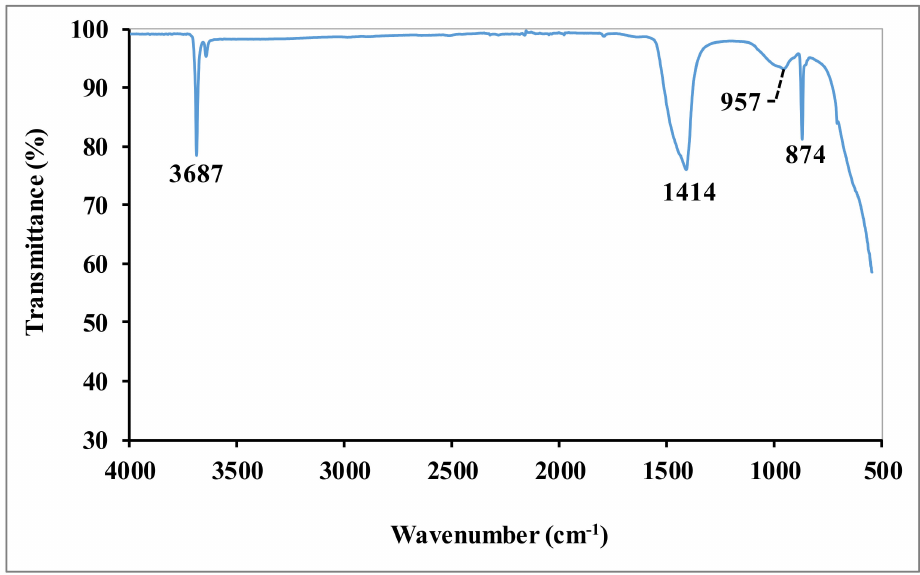
Figure 2. FTIR spectrum of the dolomitic